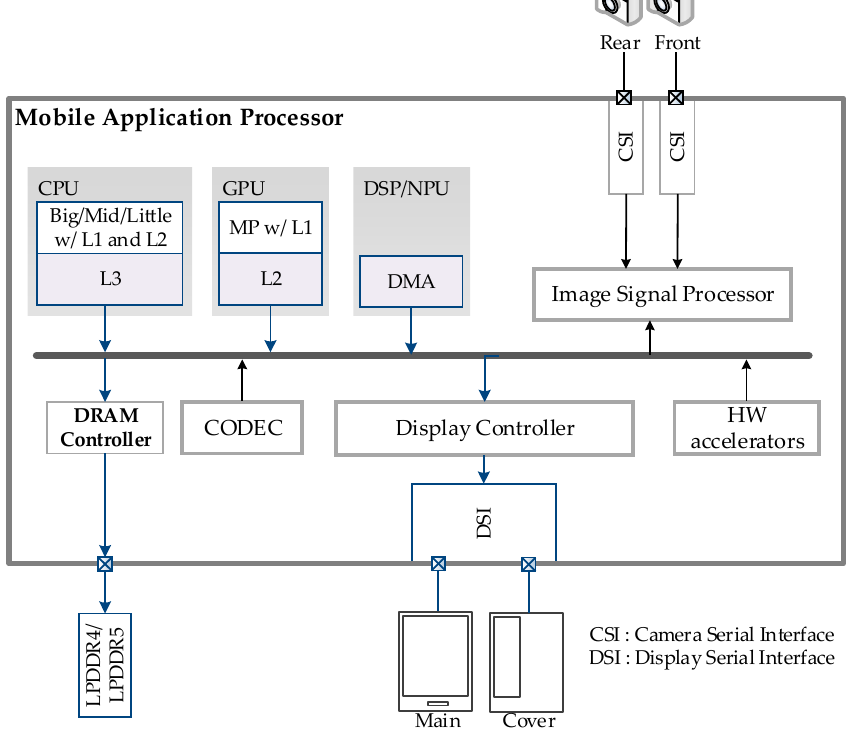
Figure 1. System configuration in the mobile application processor. Abbreviations: CPU, central processing unit; GPU, graphics processing unit; DSP, digital signal processor; NPU, neural processing unit; DMA (Direct Memory Access); DRAM (dynamic random-access memory); HW (HardWare); LPDDR (Low-Power Double Data Rate).